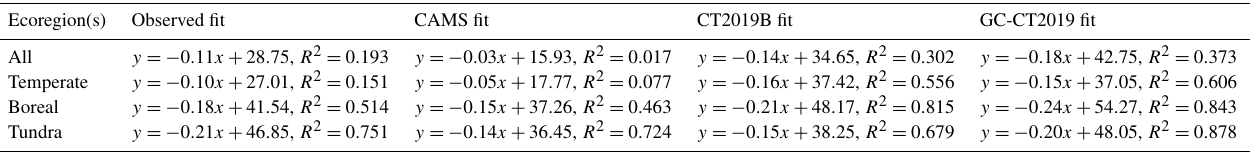
Figure 8. Correlations between SCA and HDD using OCO-2 and NNG seasonal cycle fits (a) , CAMS seasonal cycle fits (b) , CT2019B seasonal cycle fits (c) , and GC-CT2019 seasonal cycle fits (d) . Linear regressions are plotted for all zones, as well as separately for temperate, boreal, and tundra regions. Table 4. Linear regression equations and correlation coefficients for the correlations in Fig. 8 in which SCA is correlated against HDD for observed and model-derived results. Linear regressions were calculated considering all 5 ◦ latitude by 20 ◦ longitude zones and then separately for zones in temperate, boreal, and tundra